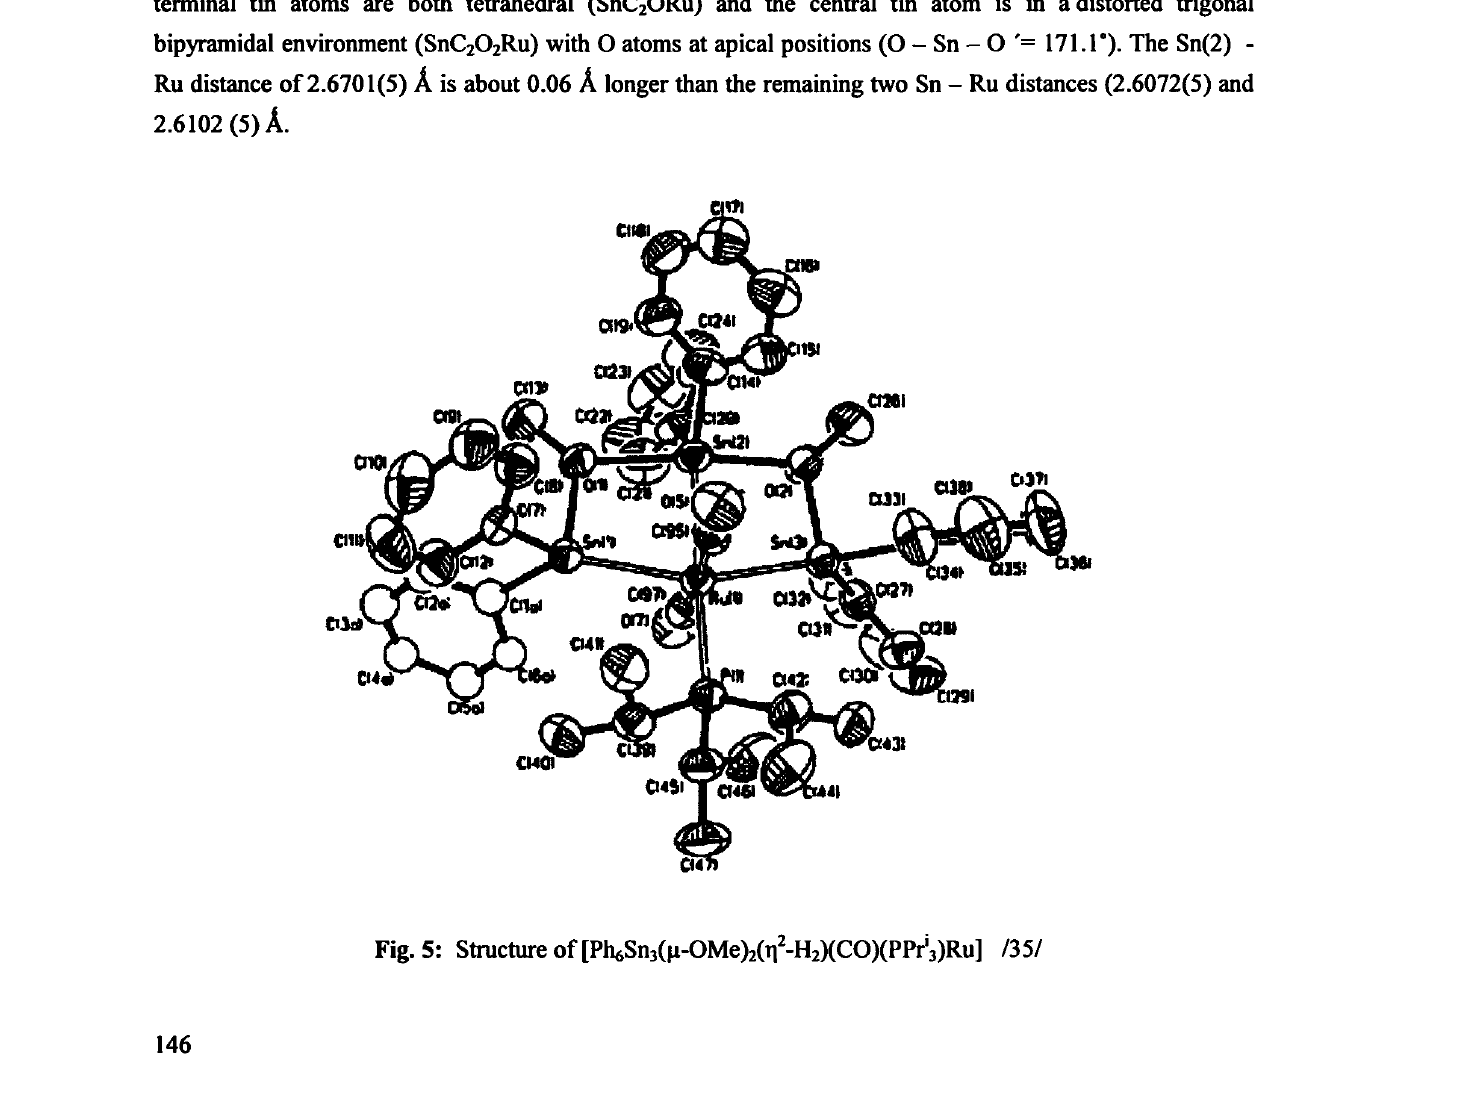
Fig. 5: Structure of [Ph